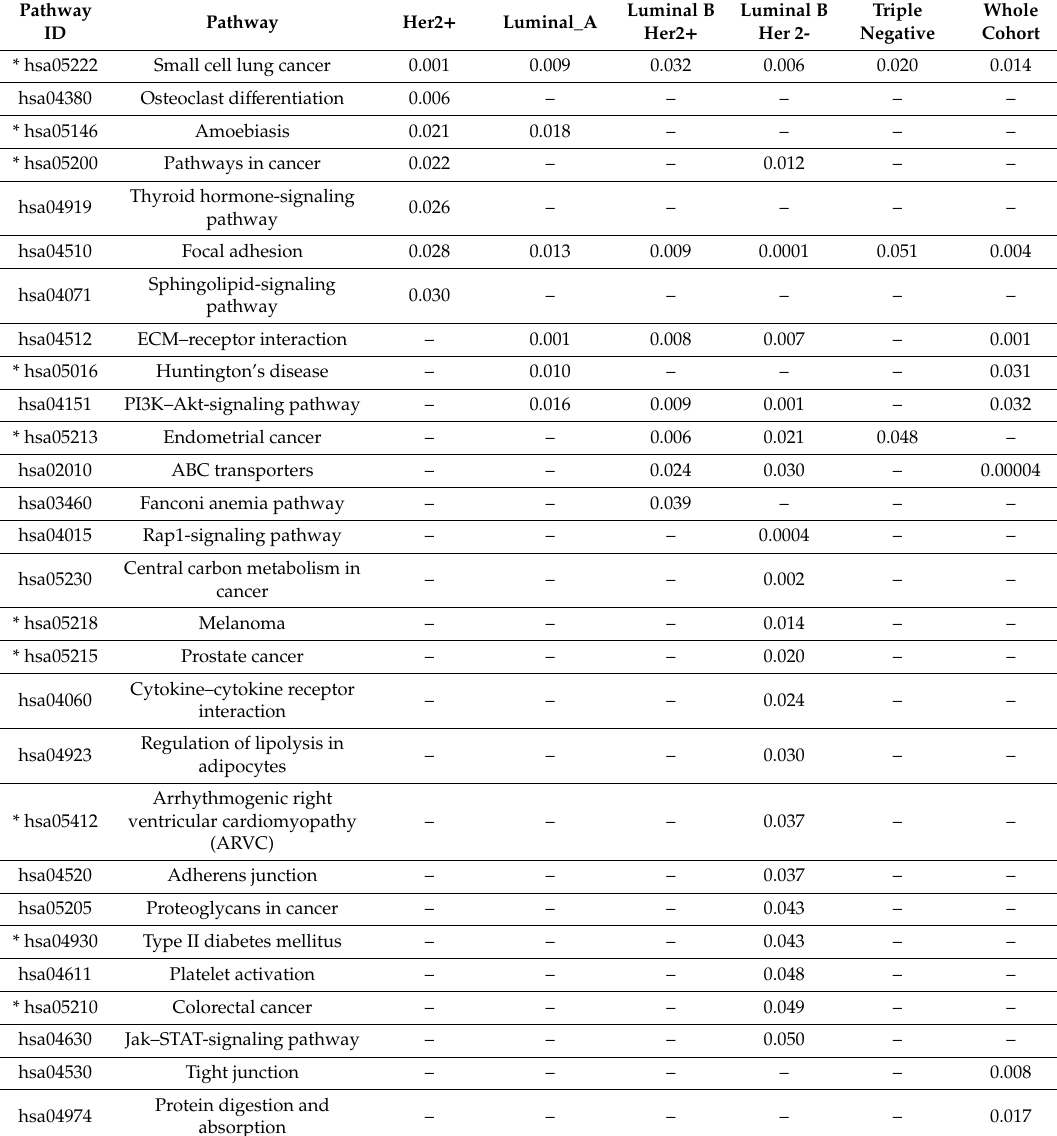
Table 2. Subtype-based pathway